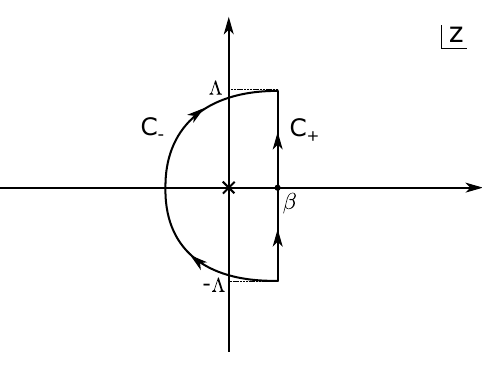
Figure 2 . Integration contour in the complex temperature z -plane. We integrate the modular invariance equation (3.2) along the vertical segment C + to derive the bound on the integrated spectral